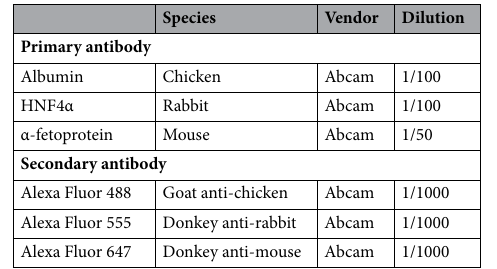
Table 2. Primary and secondary antibodies for immunofluorescent